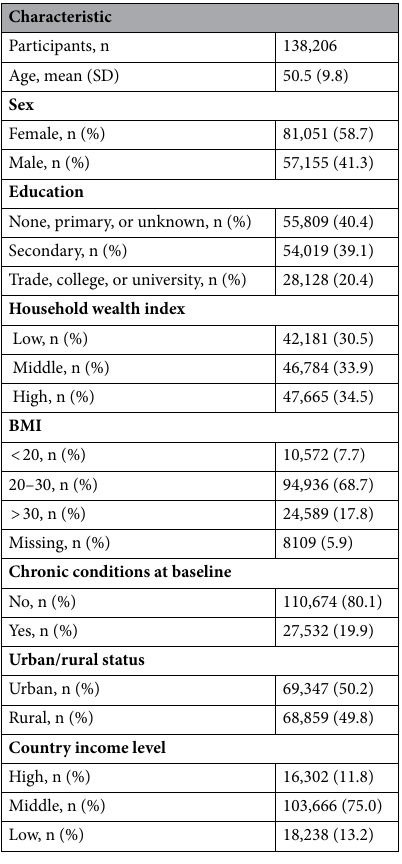
Table 1. Characteristics of 138,206 PURE participants residing in 698 communities across 22 countries that are included in the analyses of urbanization and physical activity.